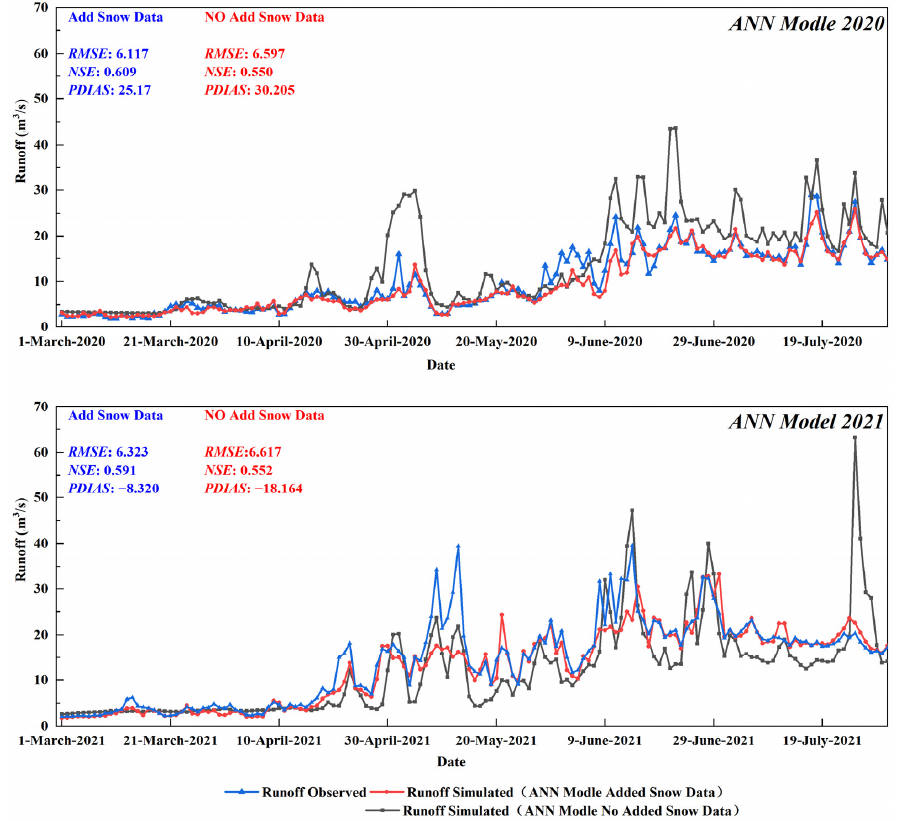
Figure 5. Simulation results for the ANN model of the Xiying River Basin from March to July, 2020 to 2021. Table 4. Evaluation parameters for the ANN model of the Xiying River Basin from March to July,